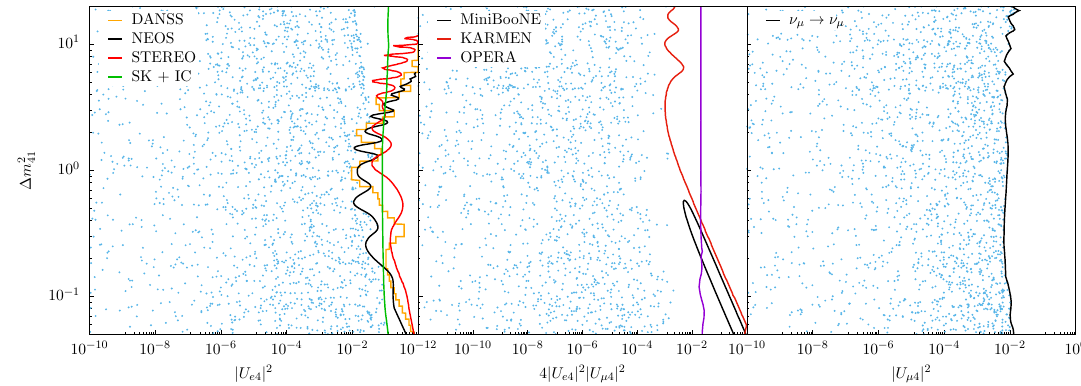
Figure 9 . One of the two ISS (2,3) realisations considered presents a Majorana state at masses comparable with SBL experiments. We show the results of the ISS (2,3) simulation (blue dots) for (cid:1) m 2 against combination of mixing angles and the experimental result at 90 % C.L.: j U e 4 j 2 (left) 41 compared to DANSS [33], NEOS [155], STEREO [156], and Super-Kamiokande and IceCube combined [147]; sin 2 2 (cid:18) (cid:22) e = 4 j U e 4 j 2 j U (cid:22) 4 j 2 (middle) compared to KARMEN2, OPERA and